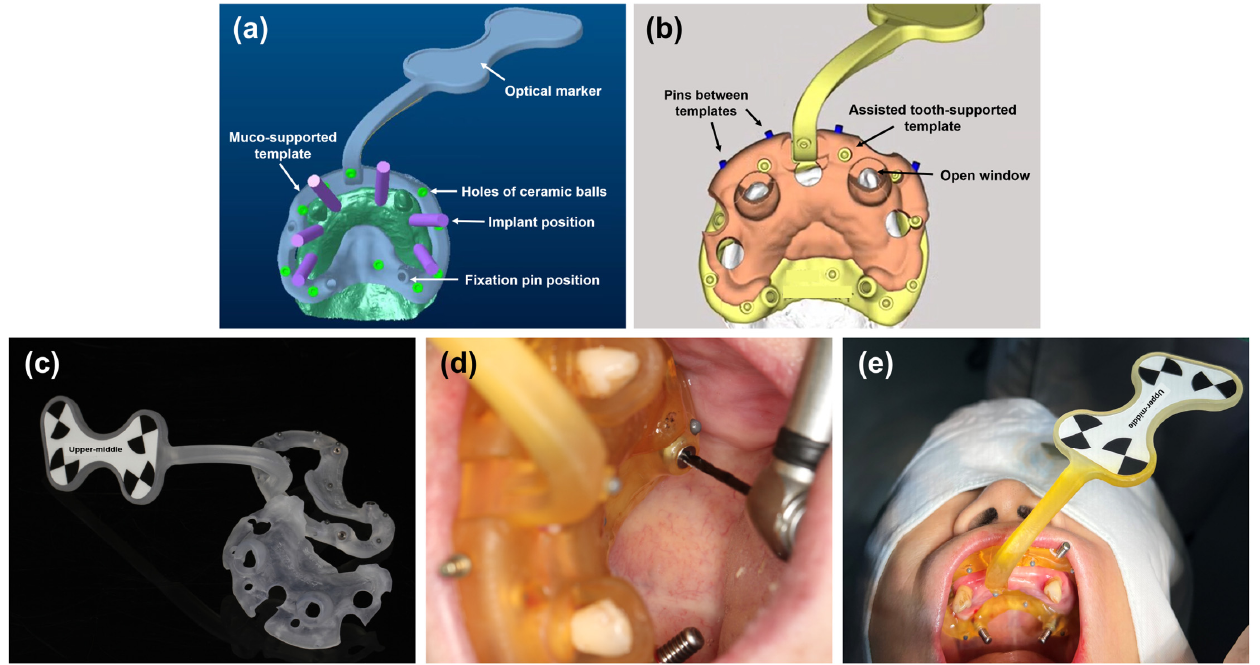
Figure 5. Design, fabrication, and fixation of the customized surgical template with positioning marker. ( a ) Design of the marker template; ( b ) design of the tooth-supported guide template; ( c ) 3D-printed surgical templates; ( d ) the fixation of templates; and ( e ) the patient with the surgical marker template.